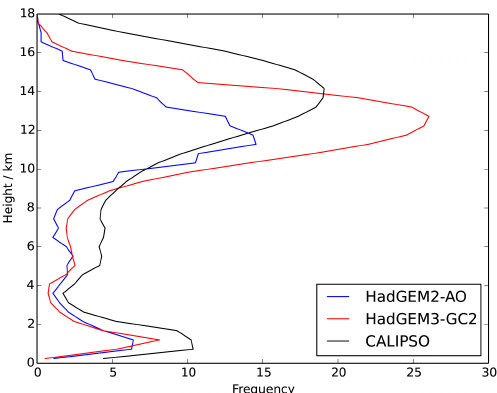
Figure 9. Tropical-mean (20 ◦ N–20 ◦ S) vertical profile of cloud fre- quency in atmosphere-only (AMIP) simulations of HadGEM2-AO and HadGEM3-GC2 using the CALIPSO simulator from COSP. The observed profile from CALIPSO is shown in